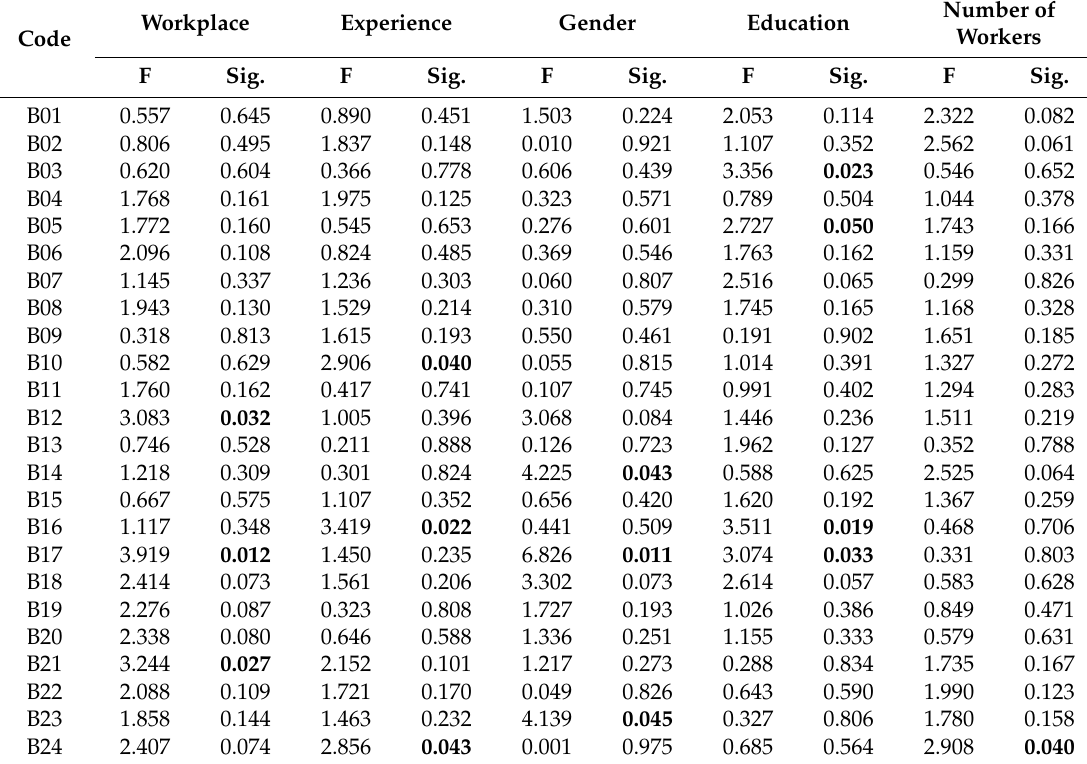
Table 4. ANOVA for the five background